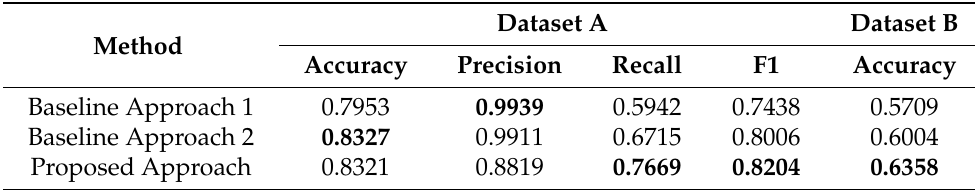
Table 2. Yoga pose grading performance comparison. The best performance is indicated by the bold fonts.